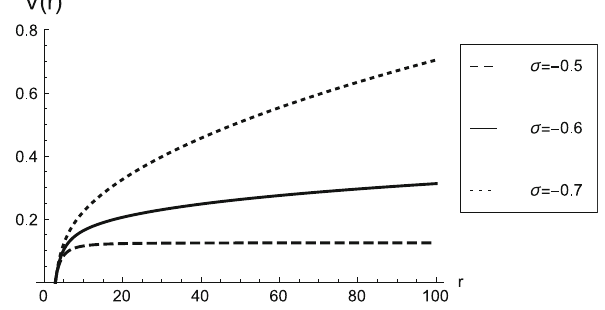
Fig. 5 The behavior of the effective potential for photons V(r) as a function of r , for σ ≤ − 1 / 2, with r S = 2 and L =